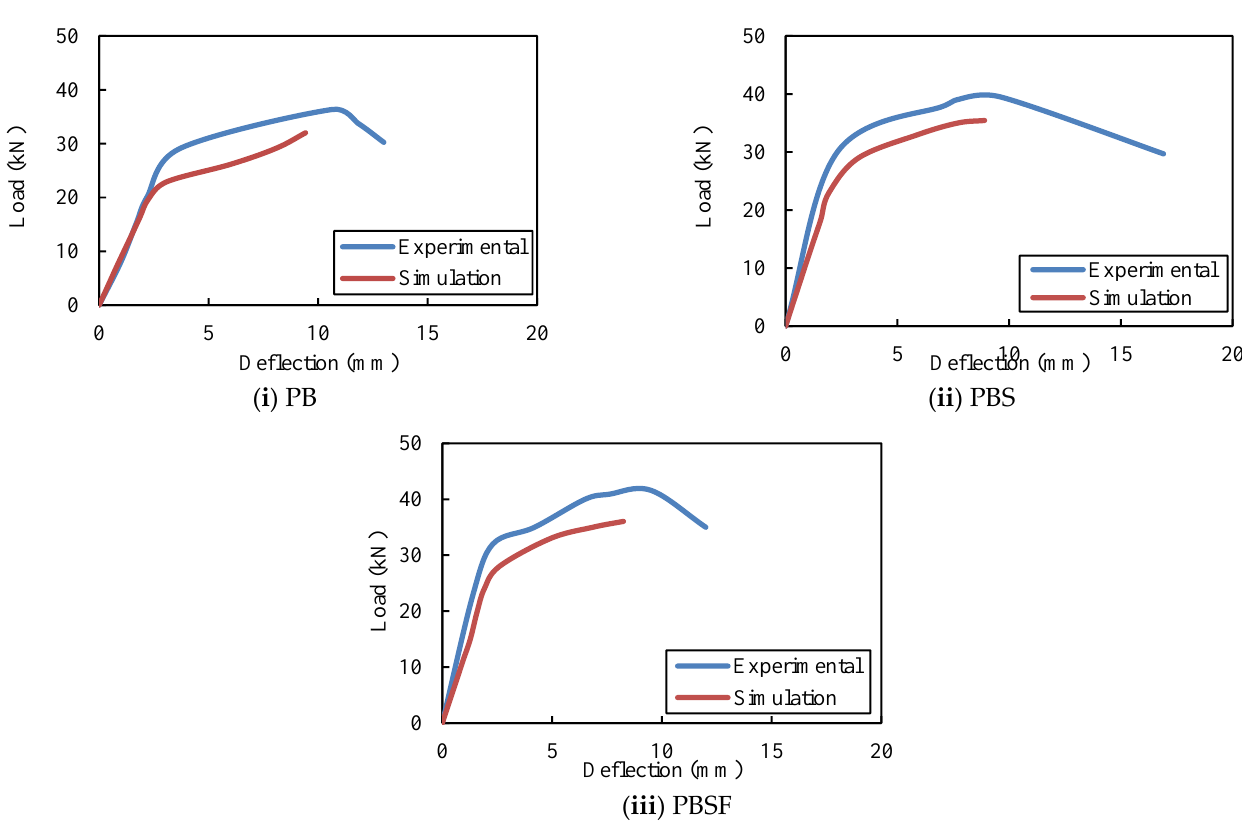
( iii ) CBSF Figure 23. ANSYS and experimental deflections of the composite CFS beams.